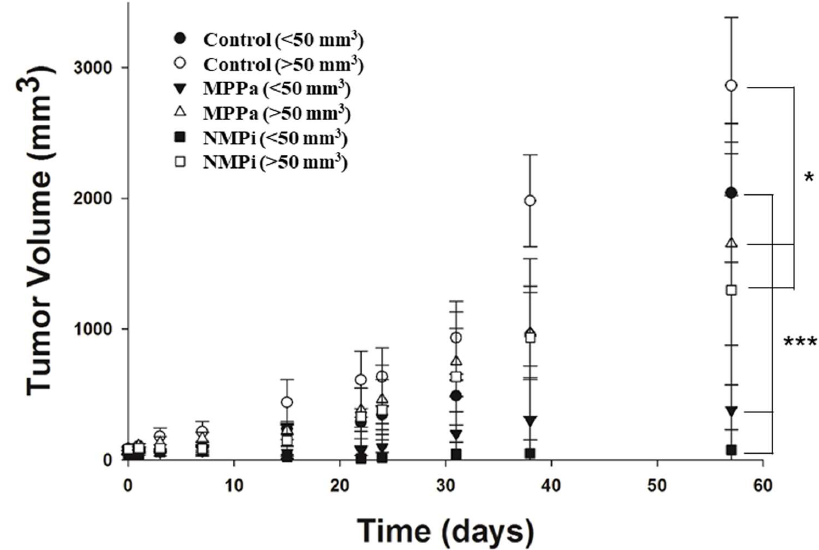
Figure 7. In vivo tumor volume changes in A549 tumor-bearing mice (small-tumor groups <50 mm 3 , and large-tumor groups >50 mm 3 ) after double injections (on Days 0 and 2, repeated two times PDT) of PBS, MPPa (2 mg/kg), or NMPi (2 mg/kg) followed by light irradiation (200 J/cm 2 ) one day after each injection (on Days 1 and 3, repeated two times PDT). Data are presented as means ± SD ( n = 5). The tumor volume (mm 3 ) was calculated as (length × width 2 )/2. Therapeutic effect was higher in the order of NMPi (<50 mm 3 ) > MPPa (<50 mm 3 ) > NMPi (>50 mm 3 ) > MPPa (>50 mm 3 ). *** p < 0.001 and * p < 0.05 (one-way ANOVA) indicate values that differ significantly from control (PBS) group in small-tumor groups (<50 mm 3 ) and in large-tumor groups (>50 mm 3 ),